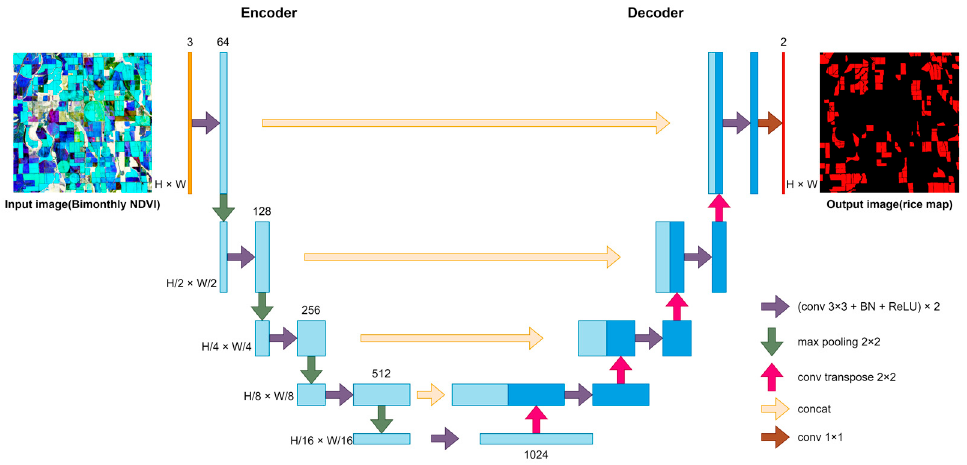
Figure 5. U-Net for rice identification [54].